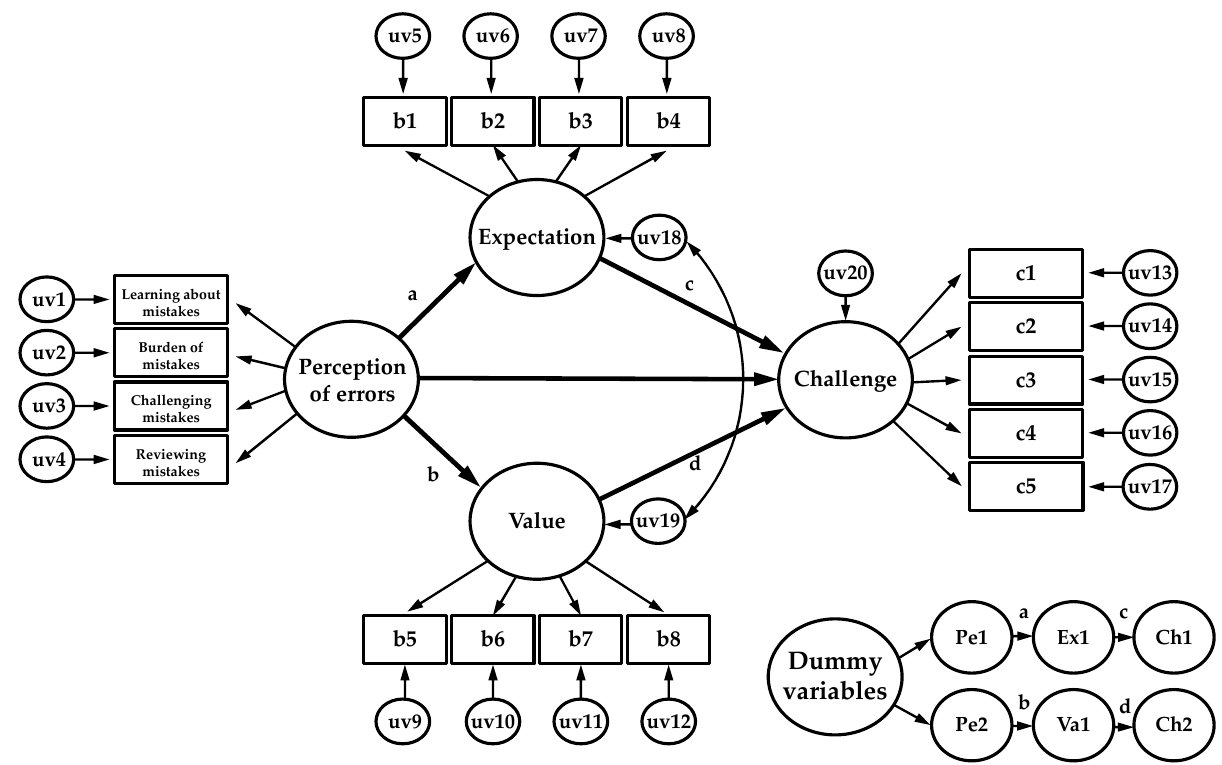
Figure 1. Structural equation modeling (SEM) analysis results. uv = unobserved variables, Pe = perception of errors, Ex = expectation, Va = values.